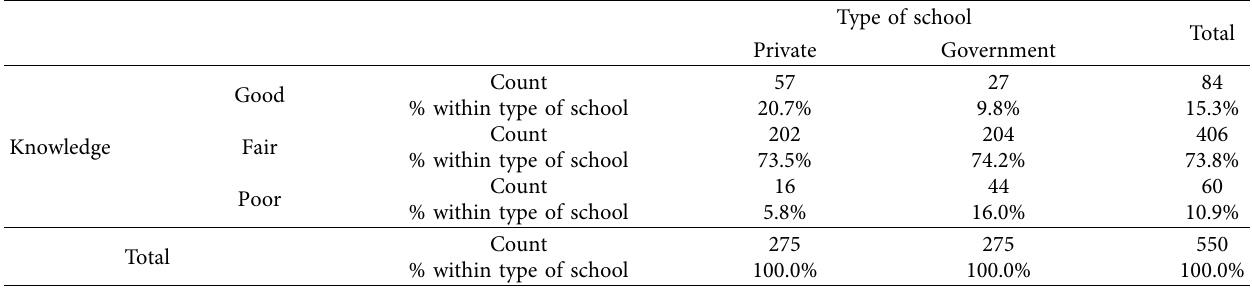
Table 3: Distribution of school teachers based on knowledge and type of school.